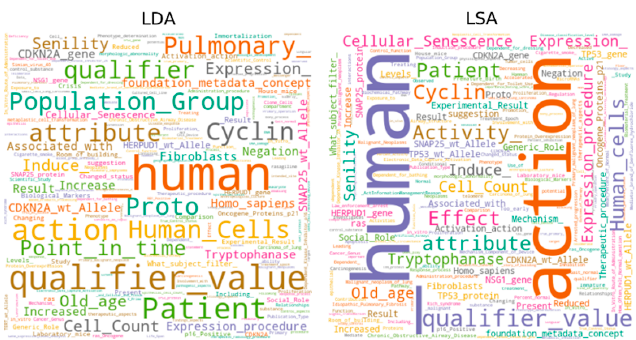
Figure 5. Word cloud of the top-1 topics on the ERI hallmark.